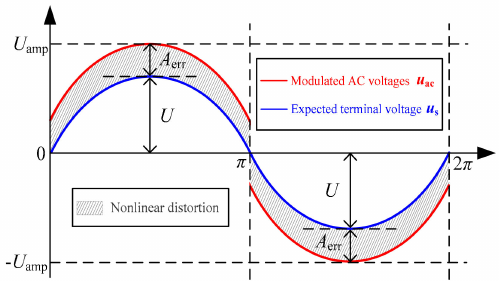
Figure 4. Diagram of inverter nonlinearity